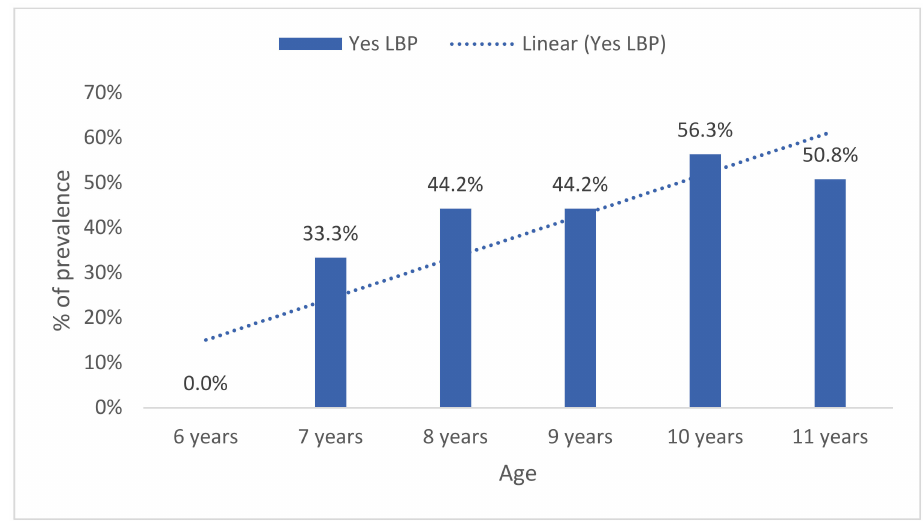
Figure 4. Last year’s prevalence of low back pain by age.